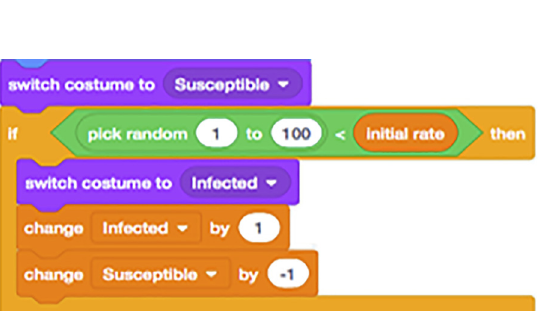
Figure 12. Coding blocks for illustrating parameters in simulation